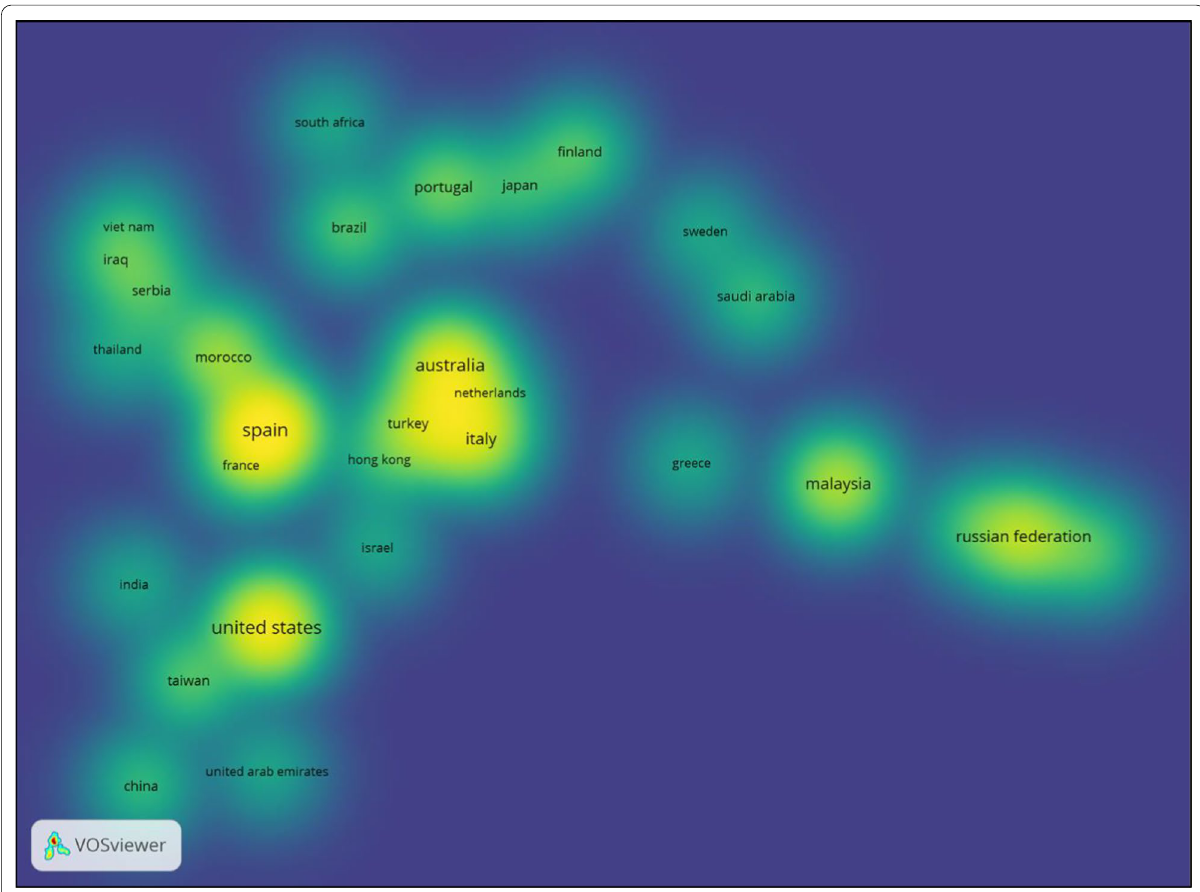
Fig. 3 Density map showing countries contributing to more than 2 publications